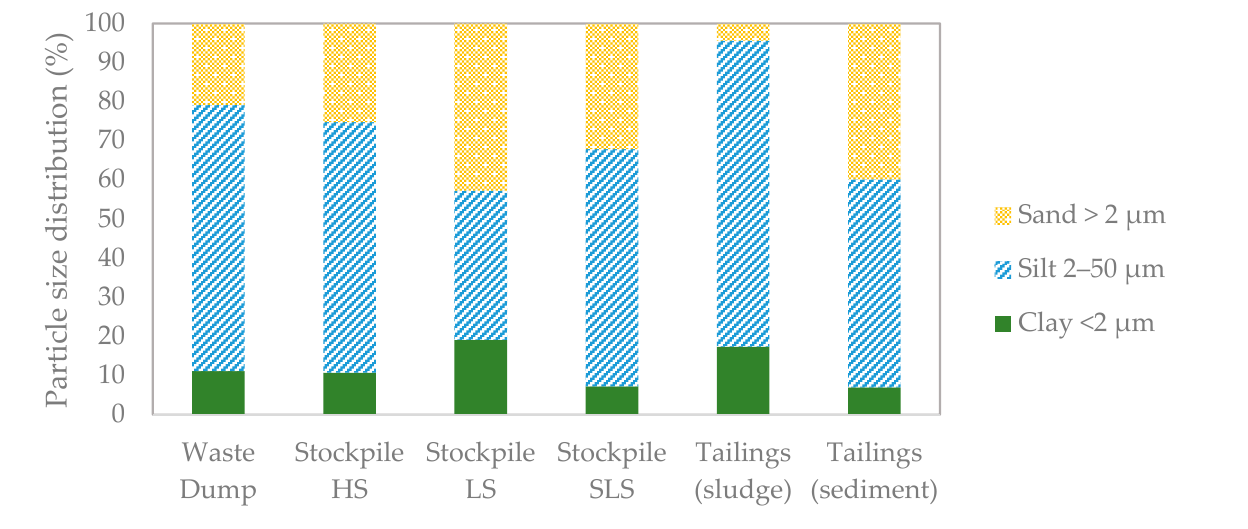
Figure 4. Particle size distribution of gold mine waste samples. Table 5. Chemical composition given as (wt.%) of major oxides of gold mine waste samples. Percent Composition